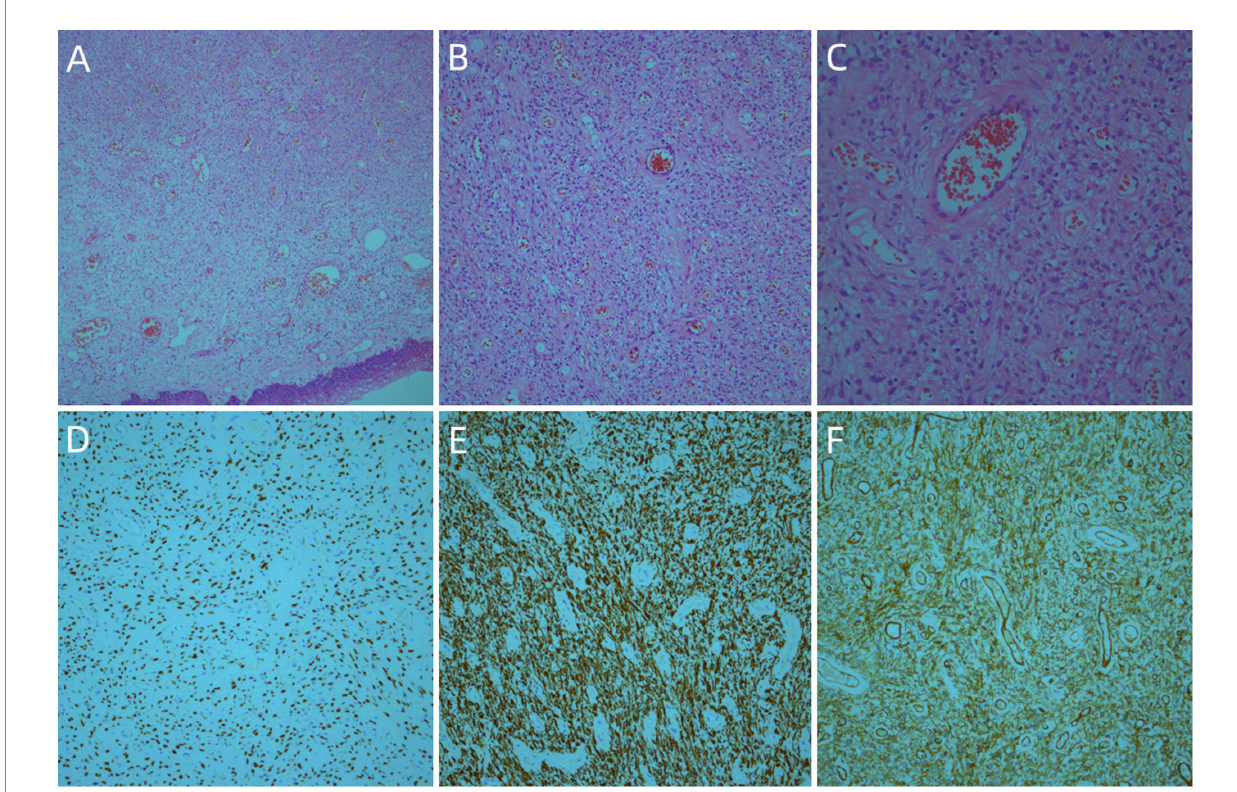
FIGURE 2 Histologic findings of this case: The tumor was located in the submucosa, and the tumor cells in the superficial area were relatively sparse. The tumor cells consisted of spindle cells and stellate cells with similar morphologies ( A , ×50) ( B , ×100) ( C , ×200). Immunohistochemistry (IHC) staining revealed a strong expression for estrogen receptors ( D , ×100), desmin ( E , ×100), and CD34 ( F ,